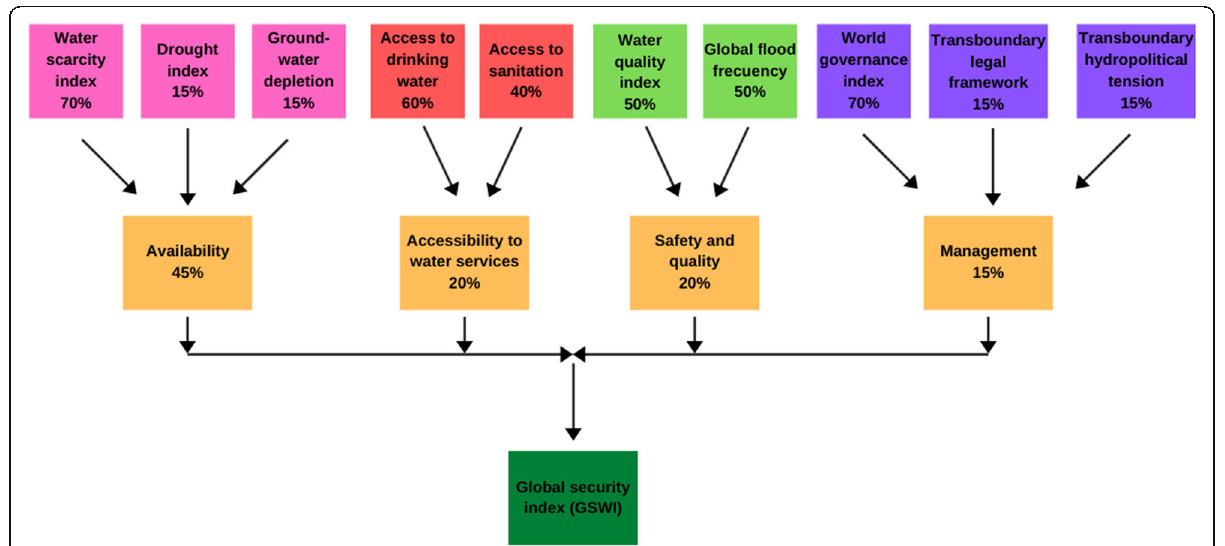
Fig. 2 Flow chart of the proposed procedure for obtaining the global water security index and respective component